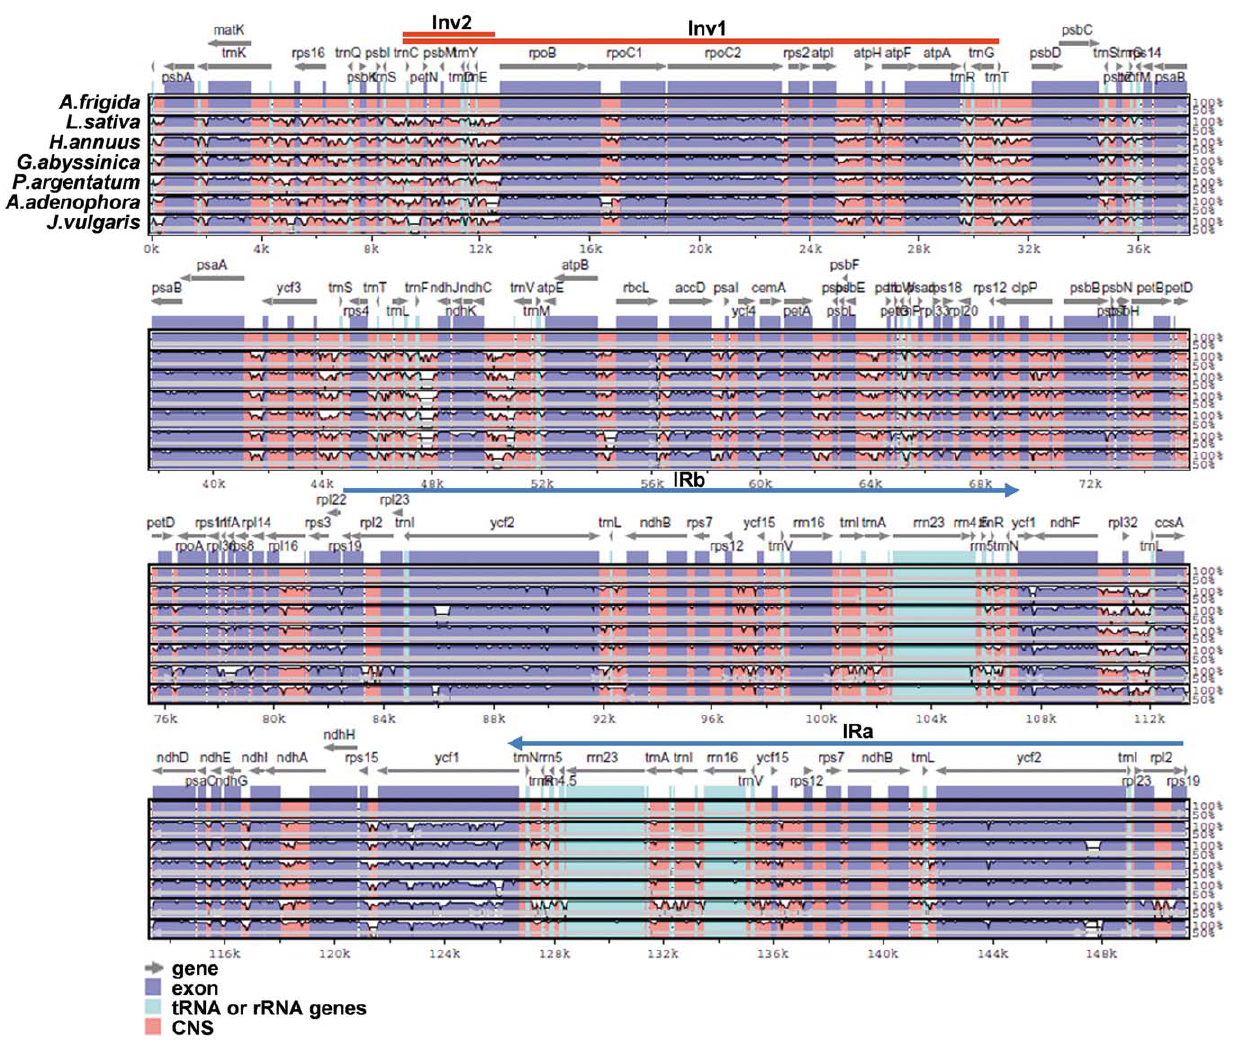
Figure 2. Sequence alignment of seven sequenced cp genomes in the Asteraceae family. Sequences of chloroplast genomes were aligned and compared using mVISTA program. A cut-off of 70% identity was used for the plot and the Y-scale represents the percent identity ranging from 50–100%. Blue represents exons, green-blue represents tRNA and rRNA genes, and pink represents conserved non-coding sequences (CNS). Grey arrows the direction of transcription; horizontal blue lines indicate the position of IRa and IRb; horizontal red lines indicate the position of Inv1 and Inv2.